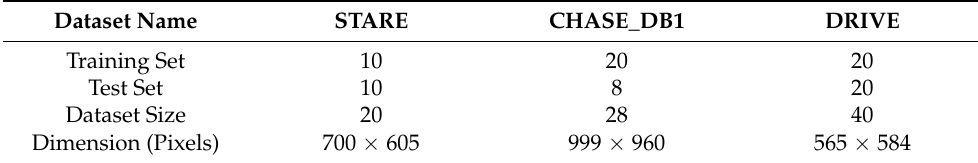
Table 4. Sample size and distribution of the experimental